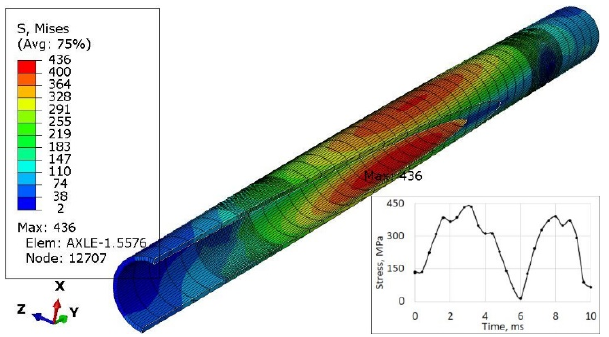
Figure 13. Stress distribution in the axle and max strengthened node 12,707 while both wheels pass the triangular road deformation.